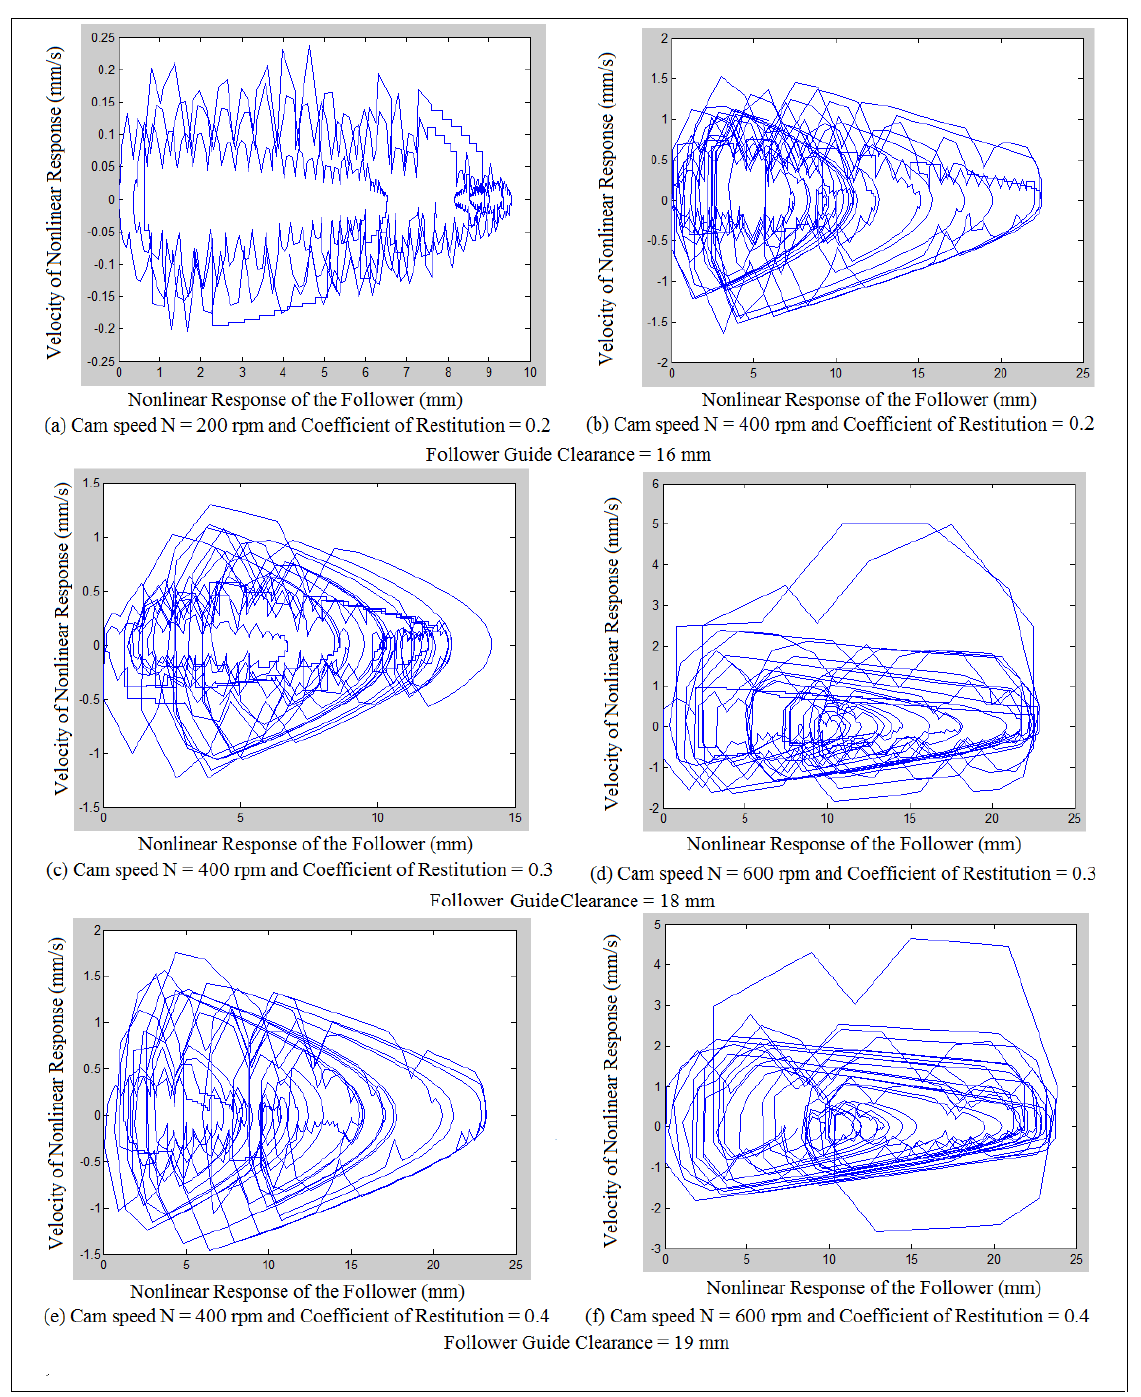
Figure 9. Phase-plane mapping of nonlinear response of the follower when the follower offsets to the left at (O = 10 mm).